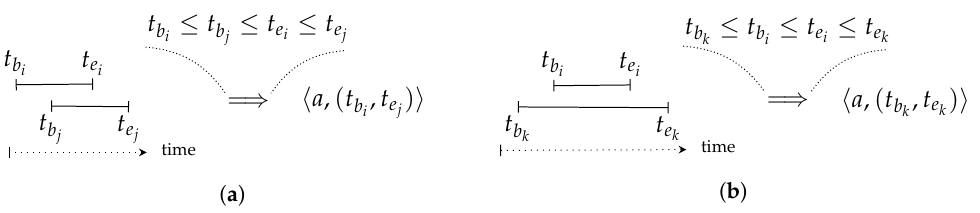
Figure 5. Consolidation rules for temporal intervals. ( a ) Overlapping rule. ( b ) Nested rule. Algorithm 2: Consolidation module for selection